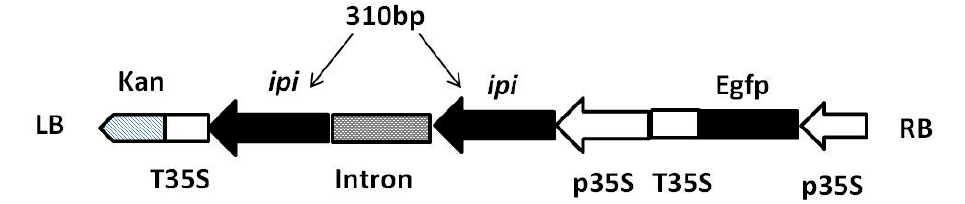
Figure 9. Construction of the pK7GWIWG2D- ipi RNA interference vector. p35S, a promoter region from the cauliflower mosaic virus (CaMV) 35S gene; T35S, a terminator fragment from the CaMV 35S gene; Egfp, enhanced green fluorescent protein; ipi , 310-bp fragment of SmIPI1 used for interference plasmid construction; LB, left border; RB, right border.